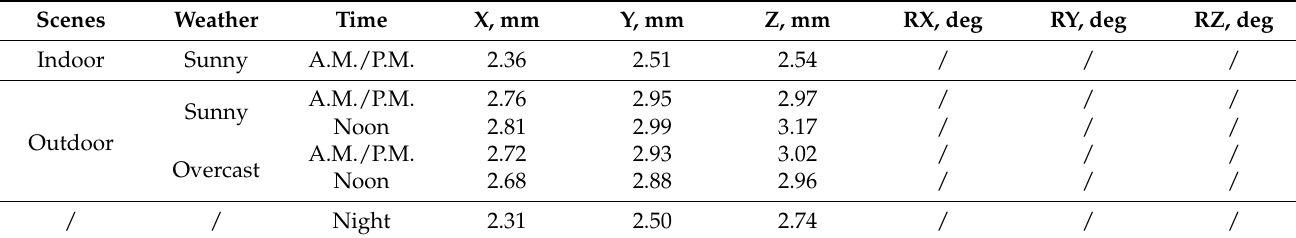
Table 5. LP error in RPS.